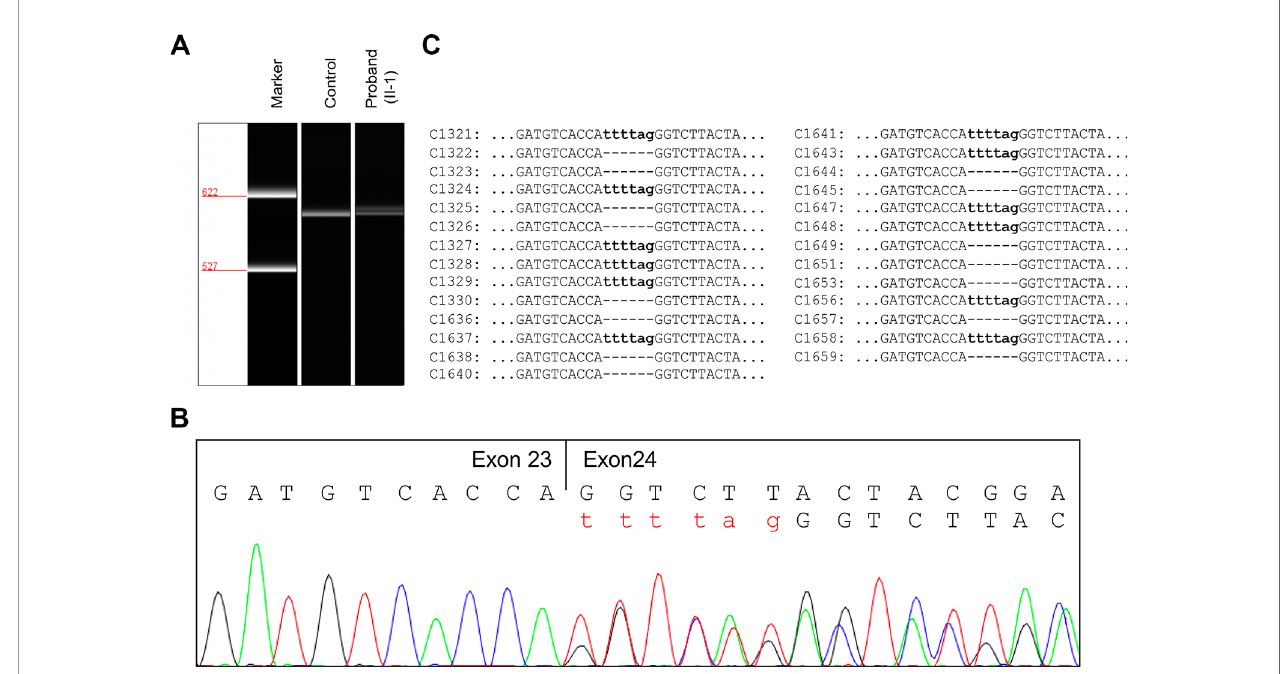
FIGURE 3 | RNA assay of the JAG1 messenger RNA (mRNA). (A) Reverse transcription (RT)-PCR analysis of JAG1 mRNA from peripheral blood mononuclear cells (PBMCs) of the proband (II-1) and a healthy female control. The complementary DNA (cDNA) fragments of 611-bp were identi fi ed in both the proband and the wild- type control. In addition, a little larger fragment was detected in the proband, but not in the wild-type. (B) cDNA sequencing revealed that JAG1 transcripts of the proband were heterozygous for c.2917-8C > A. (C) Sequencing analysis results of the pGM-T clones with the cDNA